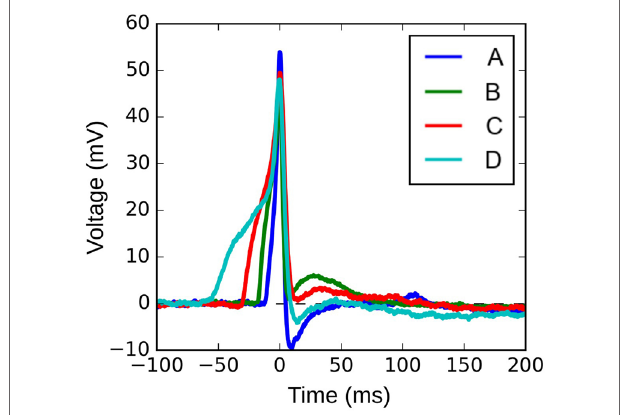
FIgURe 10 | Four instances of experimentally recorded action potentials from the mouse detrusor. The peaks have been aligned at t = 0 ms.